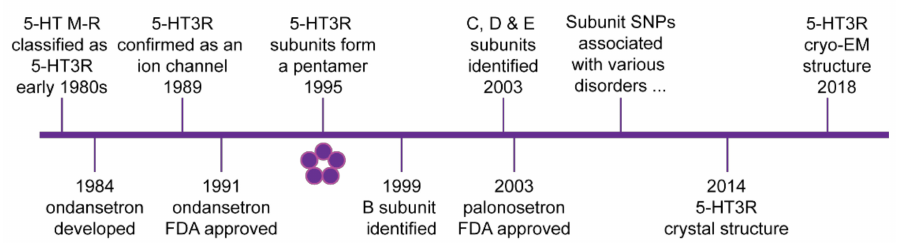
Figure 1. Schematic timeline of major discoveries in 5-HT 3 receptor biology. 5-HT 3 receptors (5- HT3R) are cysteine loop ligand gated ion channels formed by a pentamer arrangement of subunits as shown by the five circles. Initial clinical approval by the US Food and Drug Administration (FDA) of the first generation 5-HT 3 receptor antagonist ondansetron and the second-generation antagonist palonosetron are also indicated. From the early 2000s, several single nucleotide polymorphisms (SNPs) and other polymorphisms have been associated with various clinical disorders. Further details are outlined in the